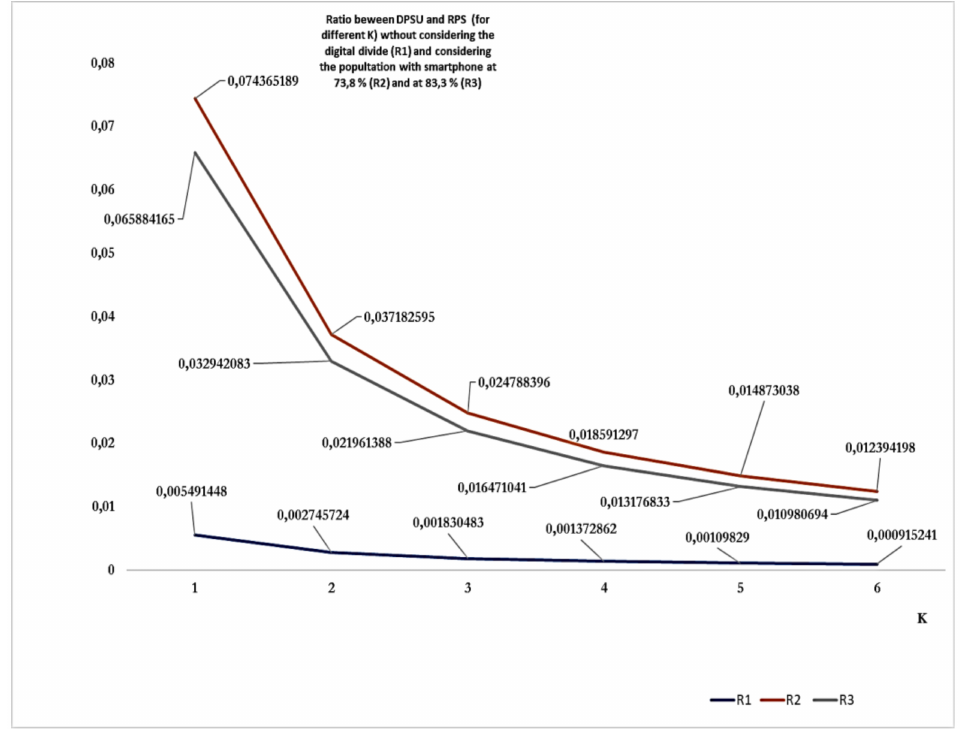
Figure 1. Ratio between the DPSU in the DCT system and the RPS (for different values of K): without the different impact of the digital divide (not considered, R1); considering the two different estimates of the digital divide at 73.8% (R2) and 83.3%